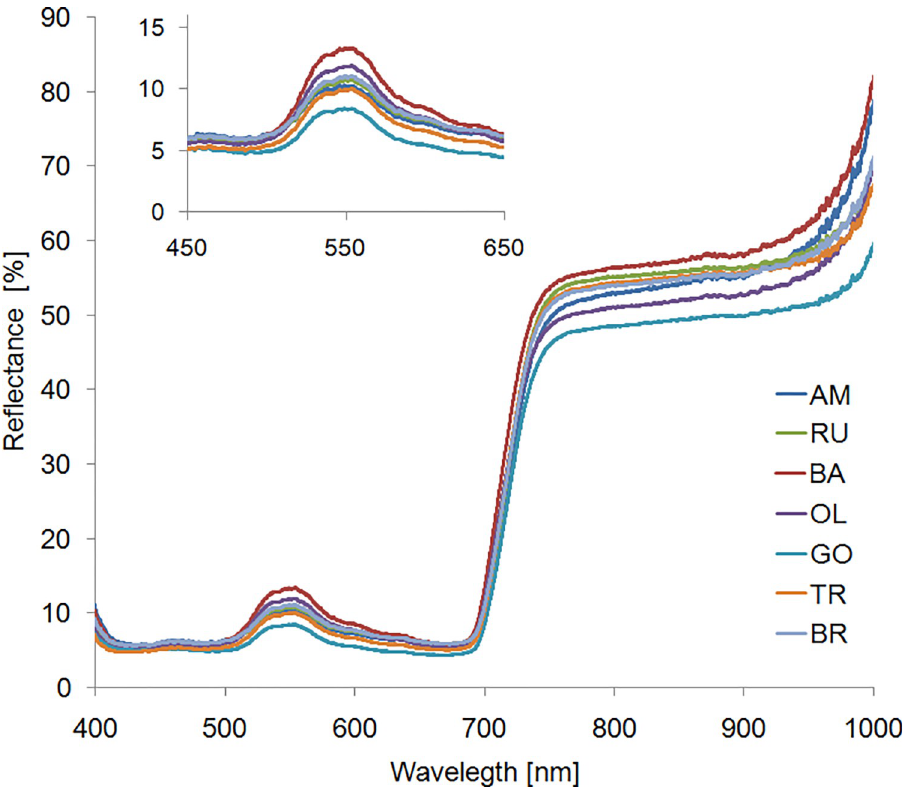
Fig 2. Intensity of light reflectance from leaves of Betula pendula plants growing in positions with various pollution degrees in Malopolska. RU–Ruczaj, BA–Batowice, AM–al. Mickiewicza, OL–Olkusz, TR–Trzebinia, GO— Gorlice,